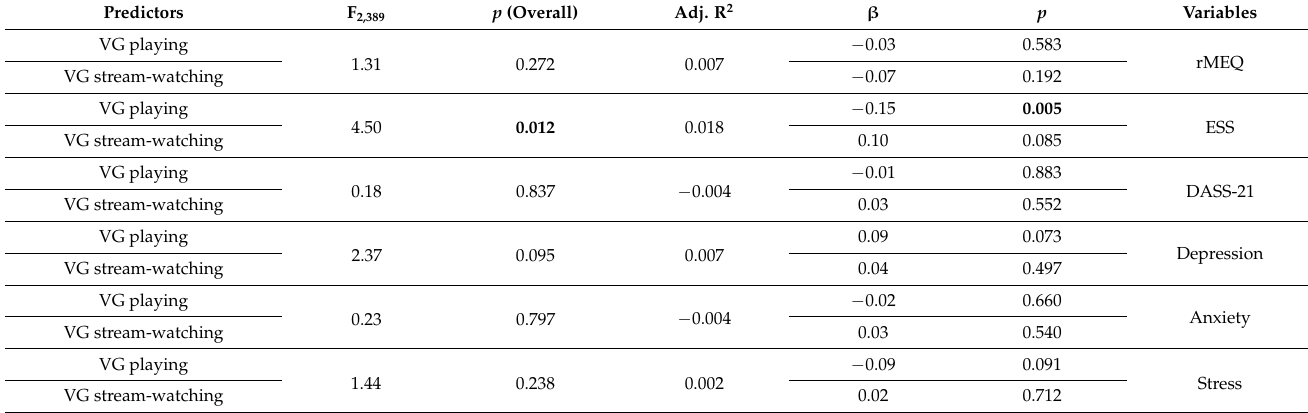
Table 4. Linear regression results for sleep variables and PSQI